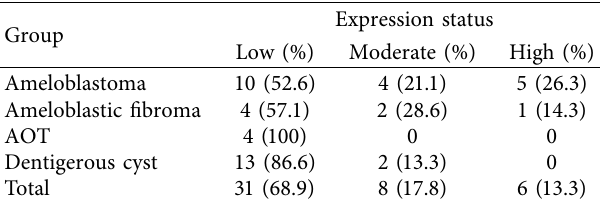
Table 3: Te status of CDC7 expression in all